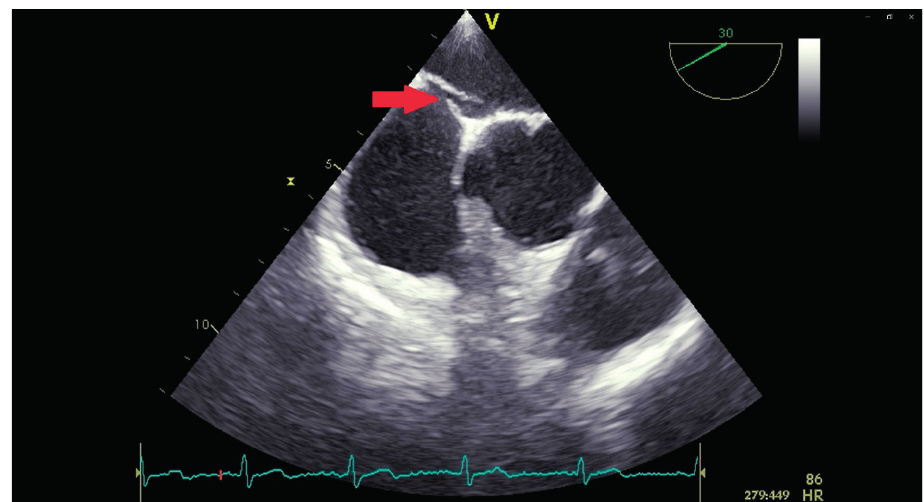
Fig. 1. Separation of the interatrial septum (indicated by red arrow).